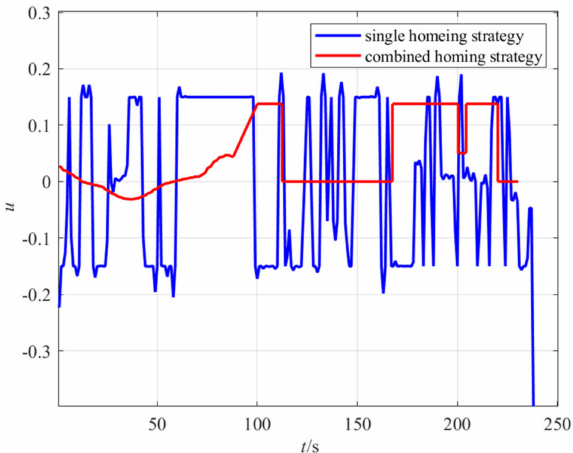
Figure 6. Comparison results of control quantities of the parafoil